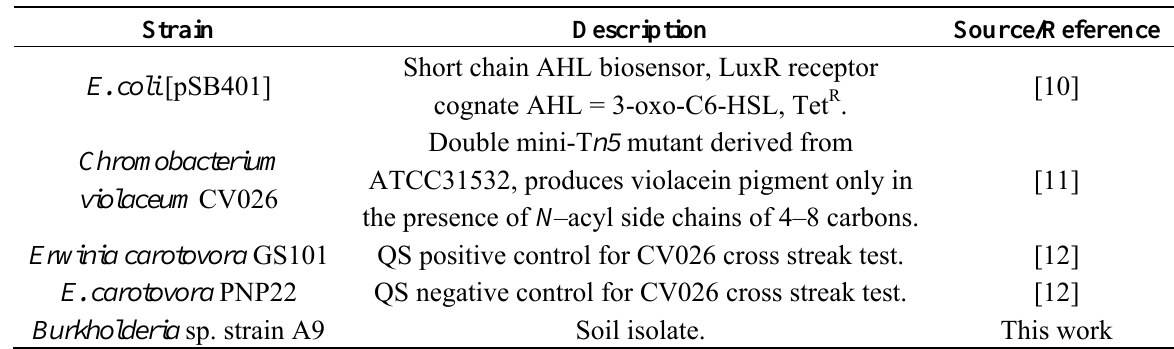
Table 1. Bacterial strains used in this